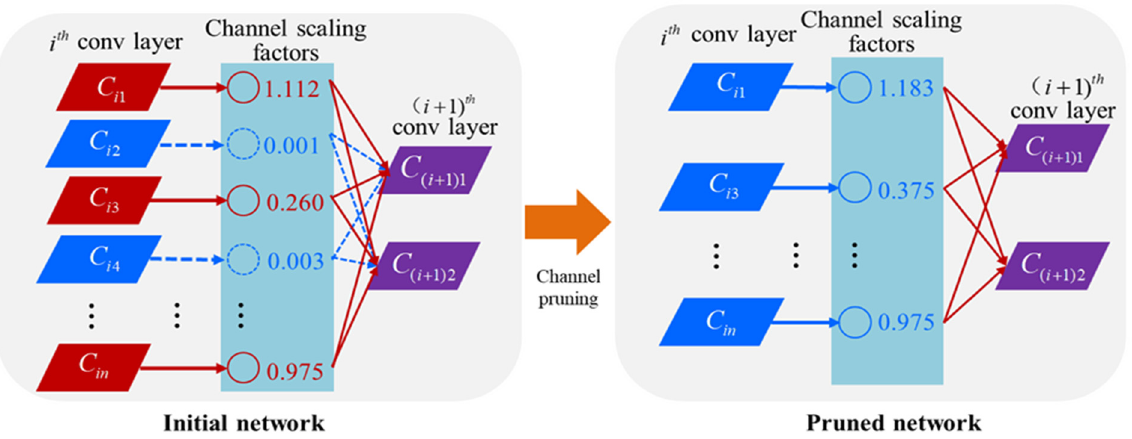
Figure 5. Schematic diagram of the principle of channel pruning based on the U-net model.